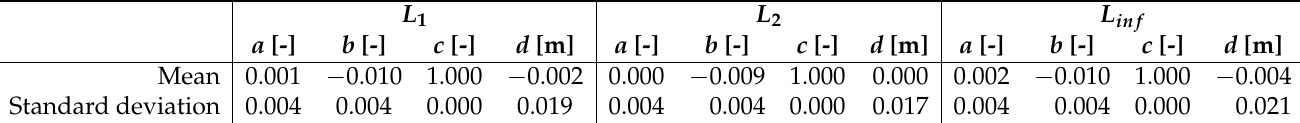
Table 4. Statistical analysis of the coefficients a, b, c and b reported by Table